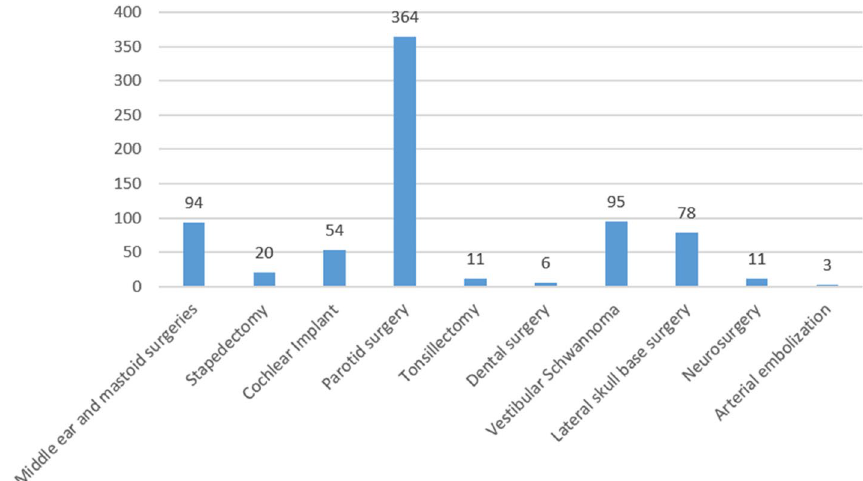
Fig. 2 Incidence of FNP in different surgeries